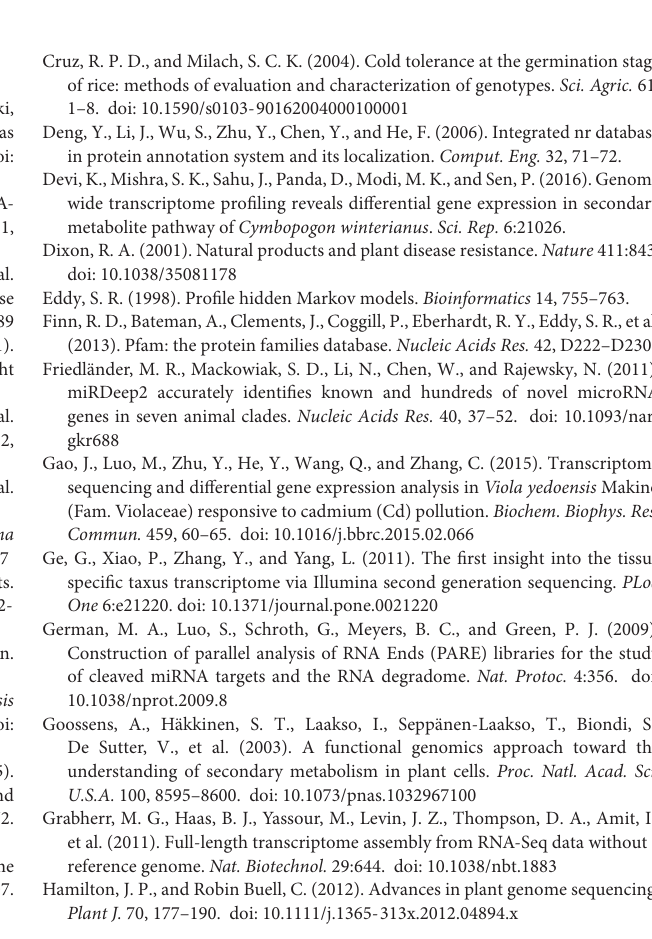
Supplementary Table 5 | KEGG enrichment analysis of differentially expressed genes between C4 and C3 groups. Supplementary Table 6 | GO enrichment analysis of differentially expressed genes between C3 and C1 groups. Supplementary Table 7 | KEGG enrichment analysis of differentially expressed genes between C3 and C1 groups. Supplementary Table 8 | GO enrichment analysis of differentially expressed genes between C4 and C2 groups. Supplementary Table 9 | KEGG enrichment analysis of differentially expressed genes between C4 and C2 groups. Supplementary Table 10 | KEGG enrichment pathway type of differentially expressed genes between C2 and C1 groups. Supplementary Table 11 | KEGG enrichment pathway type of differentially expressed genes between C4 and C3 groups. Supplementary Table 12 | KEGG enrichment pathway type of differentially expressed genes between C3 and C1 groups. Supplementary Table 13 | KEGG enrichment pathway type of differentially expressed genes between C4 and C2 groups. Supplementary Table 14 | COG classification statistics of differentially expressed genes between C2 and C1 groups. Supplementary Table 15 | COG classification statistics of differentially expressed genes between C4 and C3 groups.